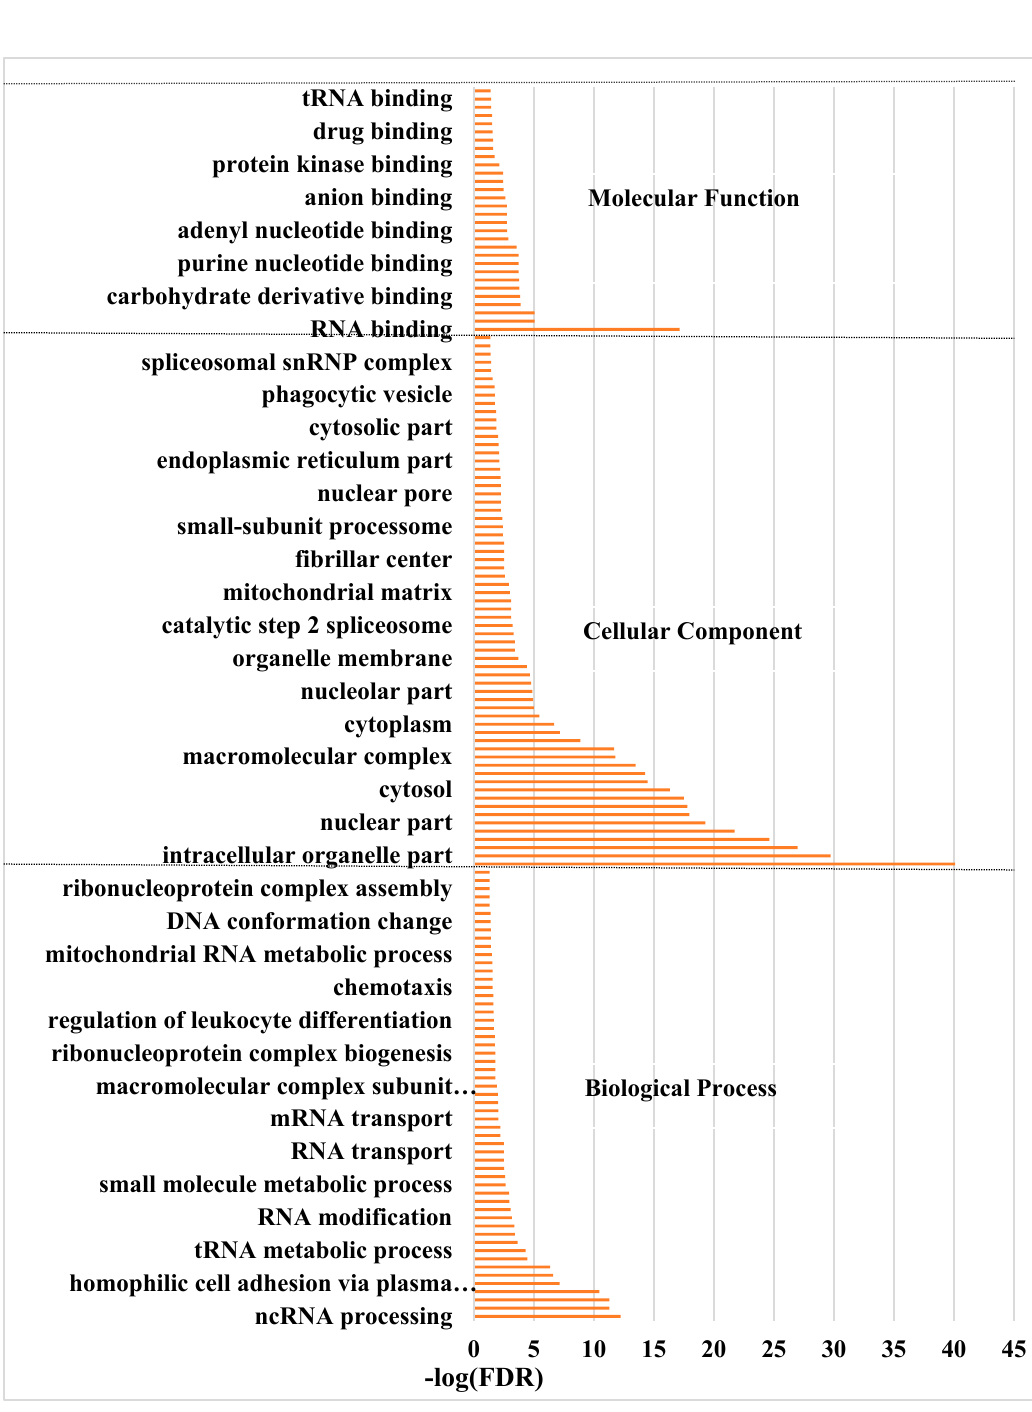
Figure 4. The significantly enriched GO terms of the differentially expressed genes between ‘lactating’ and non-‘lactating’ pigeon crops (FDR < 0.05). BP: biological process; CC: cellular component; MF: molecular function.